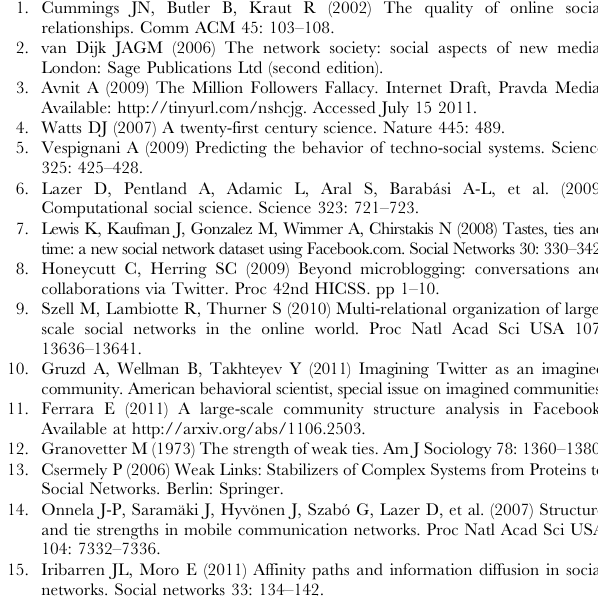
Figure S7 Internal activity for different clustering algorithms run for the snowball sample of the network ( 2 neighbors away from a random seed), from left up corner to the right: Oslom, Infomap, Moses, Louvain, Real-time community detection, and Radatools. (PNG) Figure S8 Internal activity for different clustering algorithms run for the snowball sample of the network ( 3 neighbors away from a random seed), from left up corner to the right: Oslom, Infomap, Moses, Louvain, Real-time community detection, and Radatools. (PNG) Figure S9 Internal activity for different clustering algorithms run for the subgraph of randomly chosen 200 k nodes, from left up corner to the right: Oslom, Infomap, Moses, Louvain, Real-time community detection, and Radatools. (PNG) Figure S10 Internal activity for different clustering algorithms run for the network with removed hubs, from left up corner to the right: Oslom, Infomap, Moses, Louvain, Real-time community detection, and Radatools. Figure S11 Internal activity for different clustering algorithms run for the subgraph build from 5000 randomly selected groups found by Oslom, from left up corner to the right: Oslom, Infomap, Moses, Louvain, Real-time community detection, and Radatools. (PNG) Figure S12 Activity on between-groups links when the groups are detected by Infomap in the sample without hubs. The panel reproduces the structure of Figure 3 of the main paper and of Figure S3. (A) Fraction of links in the follower networks as a function of the size of the group of origin and destination. (B) and (C) Fraction of links of different types: follower relations (black circles), links with mentions (red squares) or with retweets (green diamonds), as a function of the size of the group of origin or destination, respectively. (D) Frequency of links of the different types as a function of the group-group similarity. Ratio between the average group similarity for the links between groups